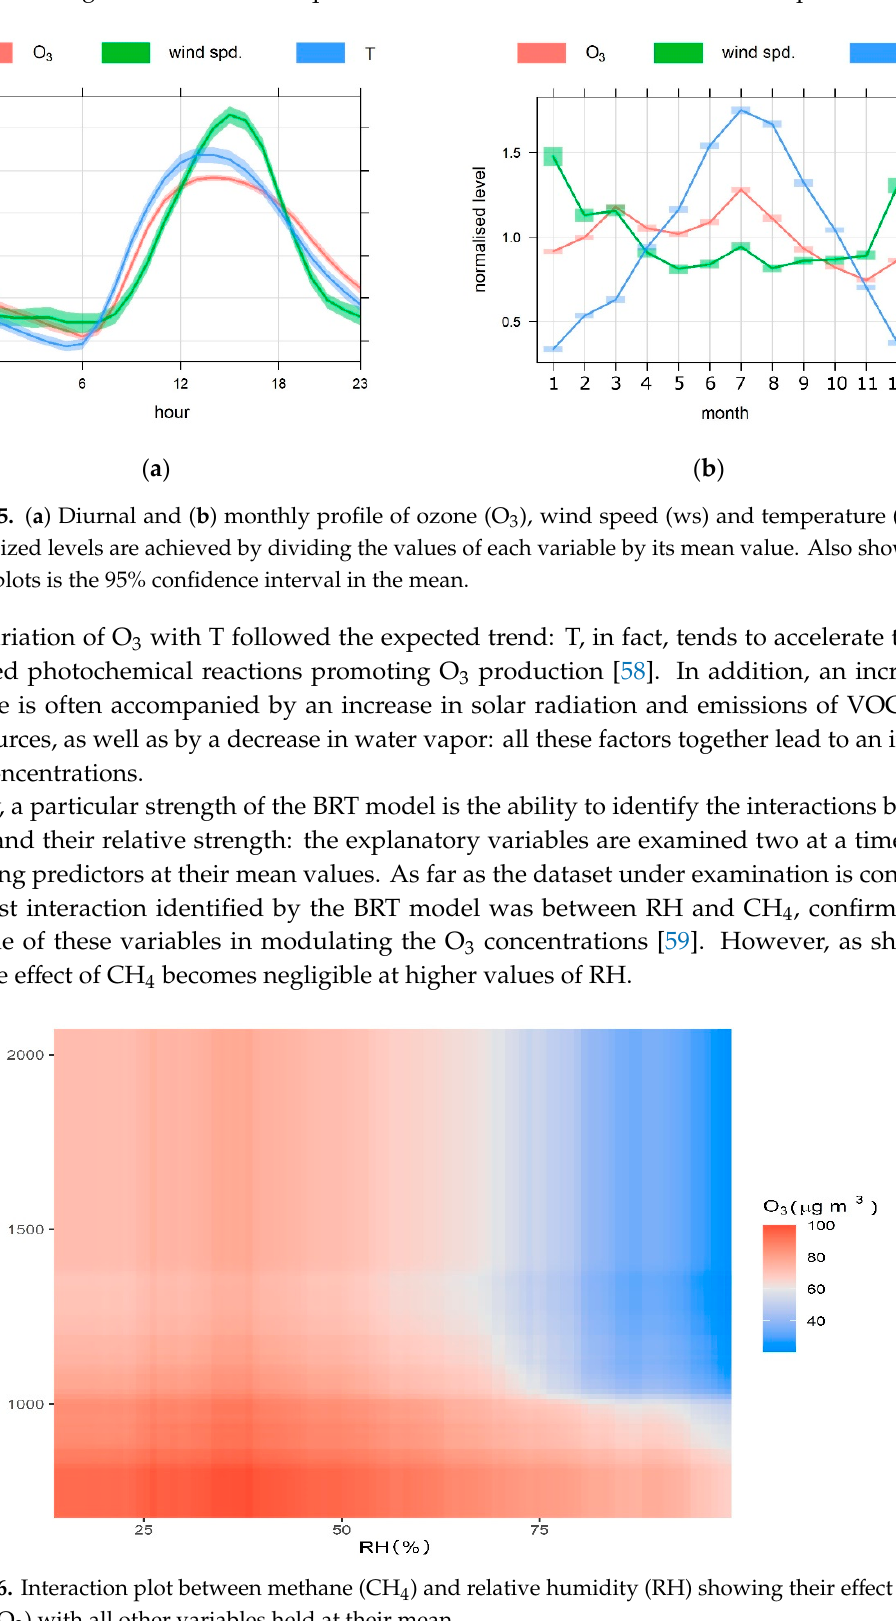
Figure 6. Interaction plot between methane (CH 4 ) and relative humidity (RH) showing their effect on ozone (O 3 ) with all other variables held at their